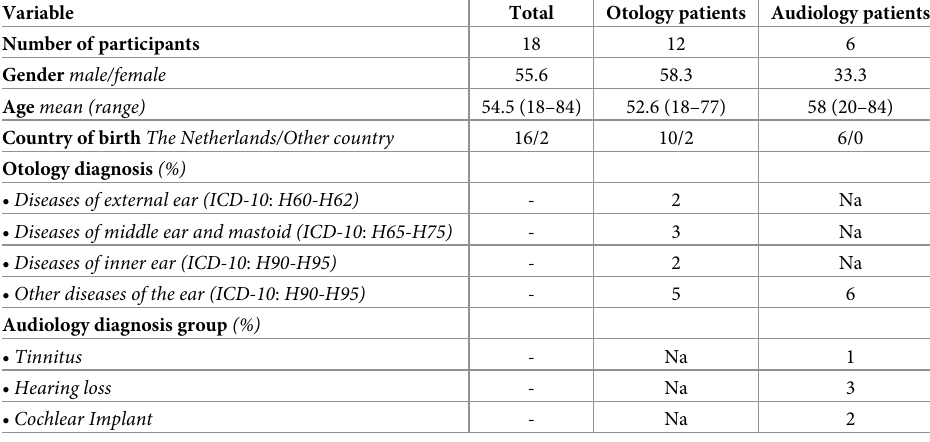
Table 2. Characteristics of the patients (N = 18) participating in the